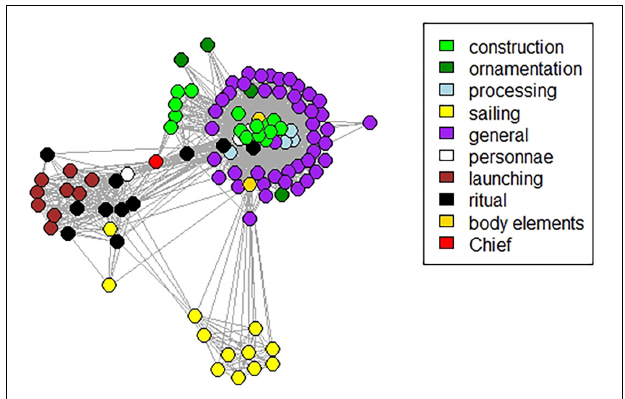
FIGURE 3 | Network visualization for the canoe use